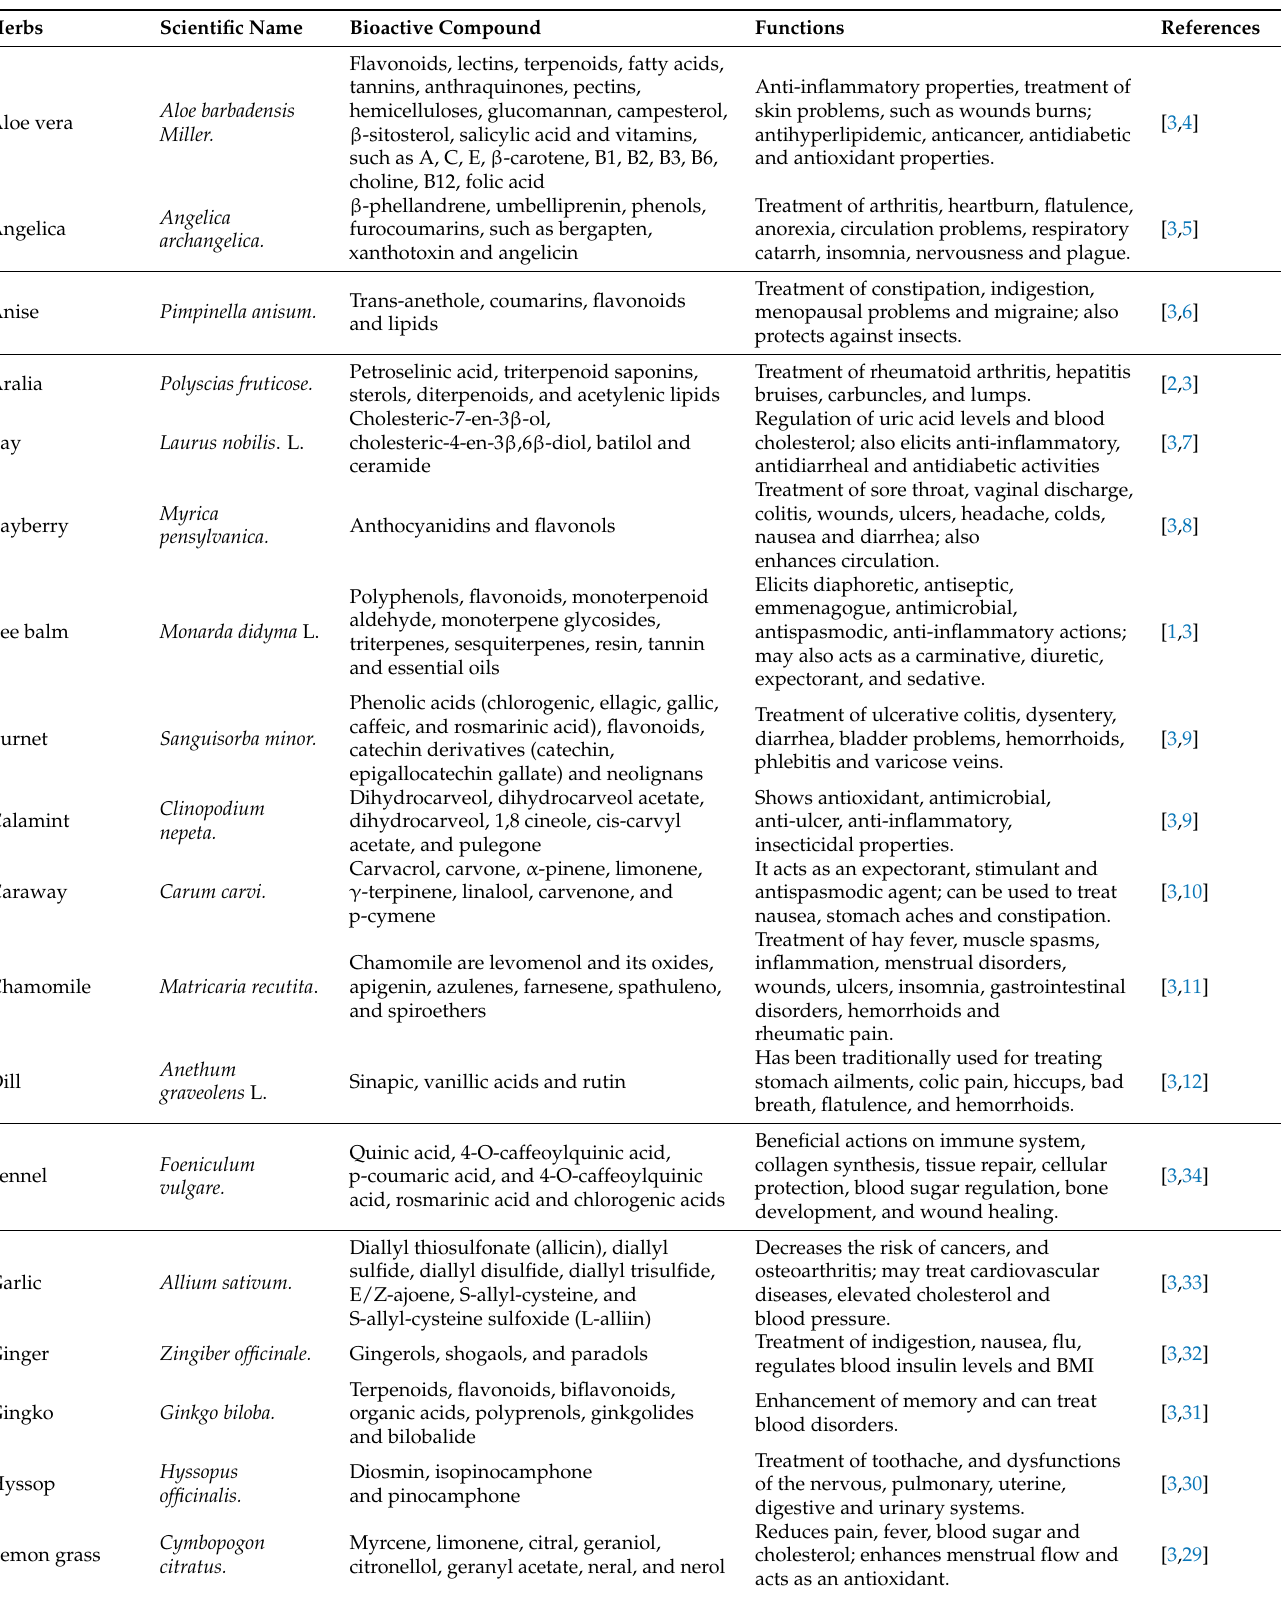
Table 1. Elucidation on the bioactive components from different herbs and their